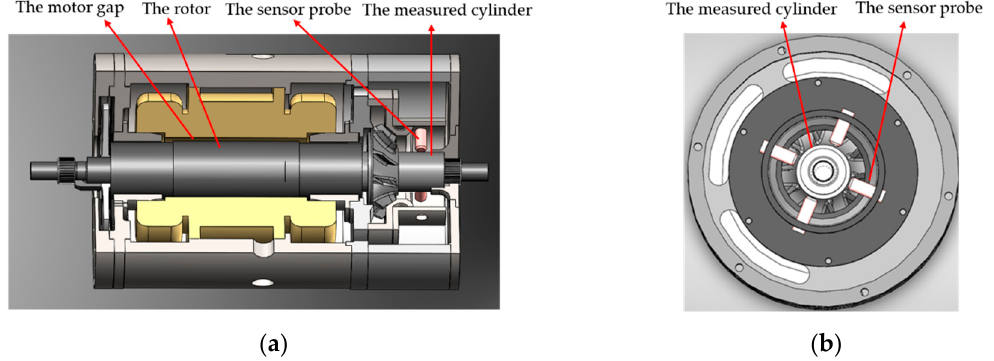
Figure 1. The structure graphing of the magnetic suspension motor: ( a ) the general design structure; ( b ) the rotor radial position detection unit.